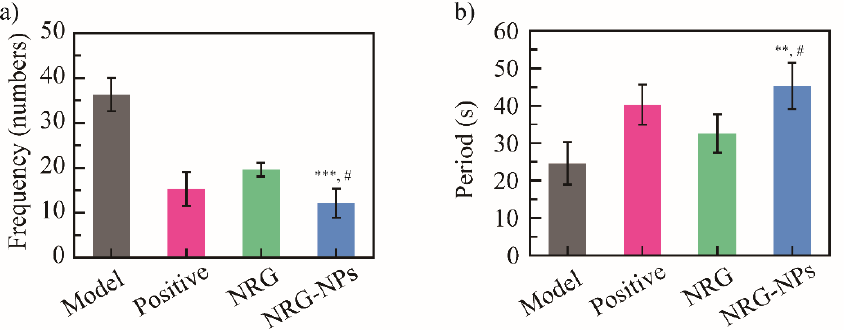
Figure 4. Cough frequency in 5 min ( a ) and cough potential period ( b ) of NRG NPs on PIC mice model ( n = 10). *** p < 0.001, ** p < 0.01 vs. blank model group; # p < 0.05 vs. NRG group. The cough potential period was 24.6 ± 5.6, 40.3 ± 5.4, 32.6 ± 5.1, and 45.3 ± 6.1 s for the